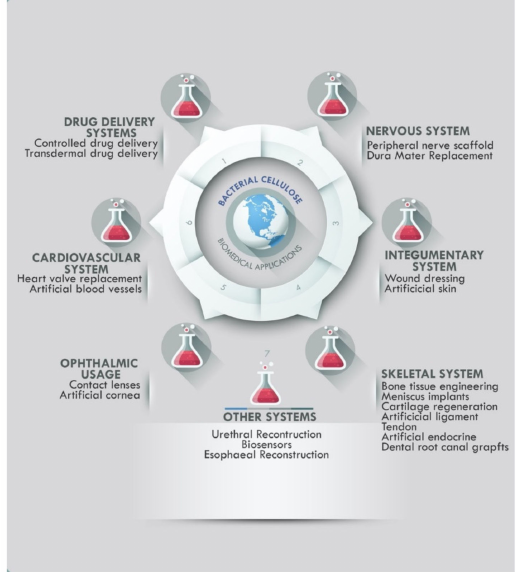
Figure 2. BC membrane technologies for drug delivery systems.